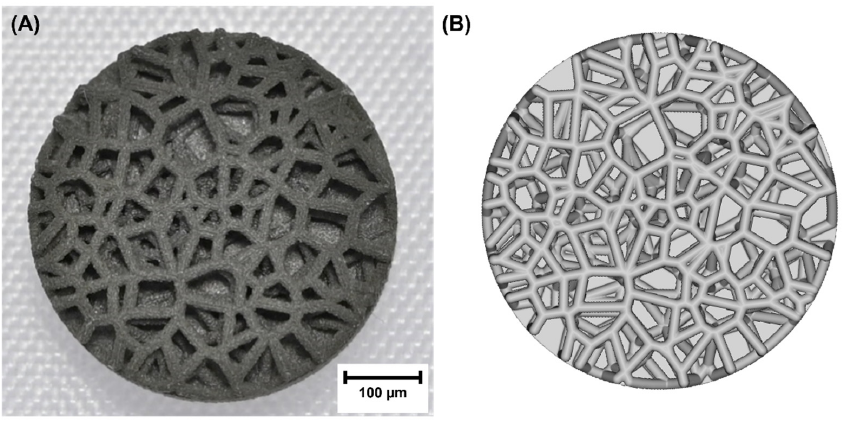
Figure 5. Macrophotography of the fabricated samples with Voronoi structure ( A ) in comparison with CAD model ( B ).